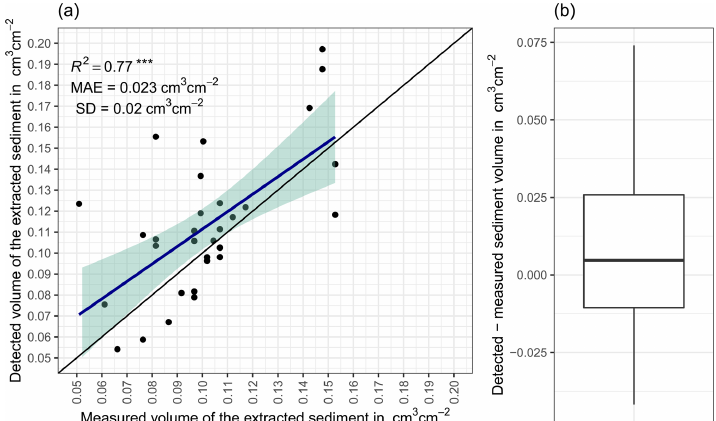
Figure A3. (a) Estimation of time-of-flight camera accuracy based on averaging two surface scans before and after the sediment extraction under controlled conditions. The x axis shows the exact sediment volume measured with a cup. The y axis represents the volume of the sediment calculated from the camera scans (according to Eq. 4). The blue line is the linear regression calculated from the measured and detected volume. The green shadow shows the confidence interval of 95% for the linear regression slope. MAE is the mean absolute error, SD is standard deviation, and R 2 is the coefficient of determination. (b) Measured sediment volume subtracted from the detected sediment volume for all measurements. ∗∗∗ p ≤ 0 .